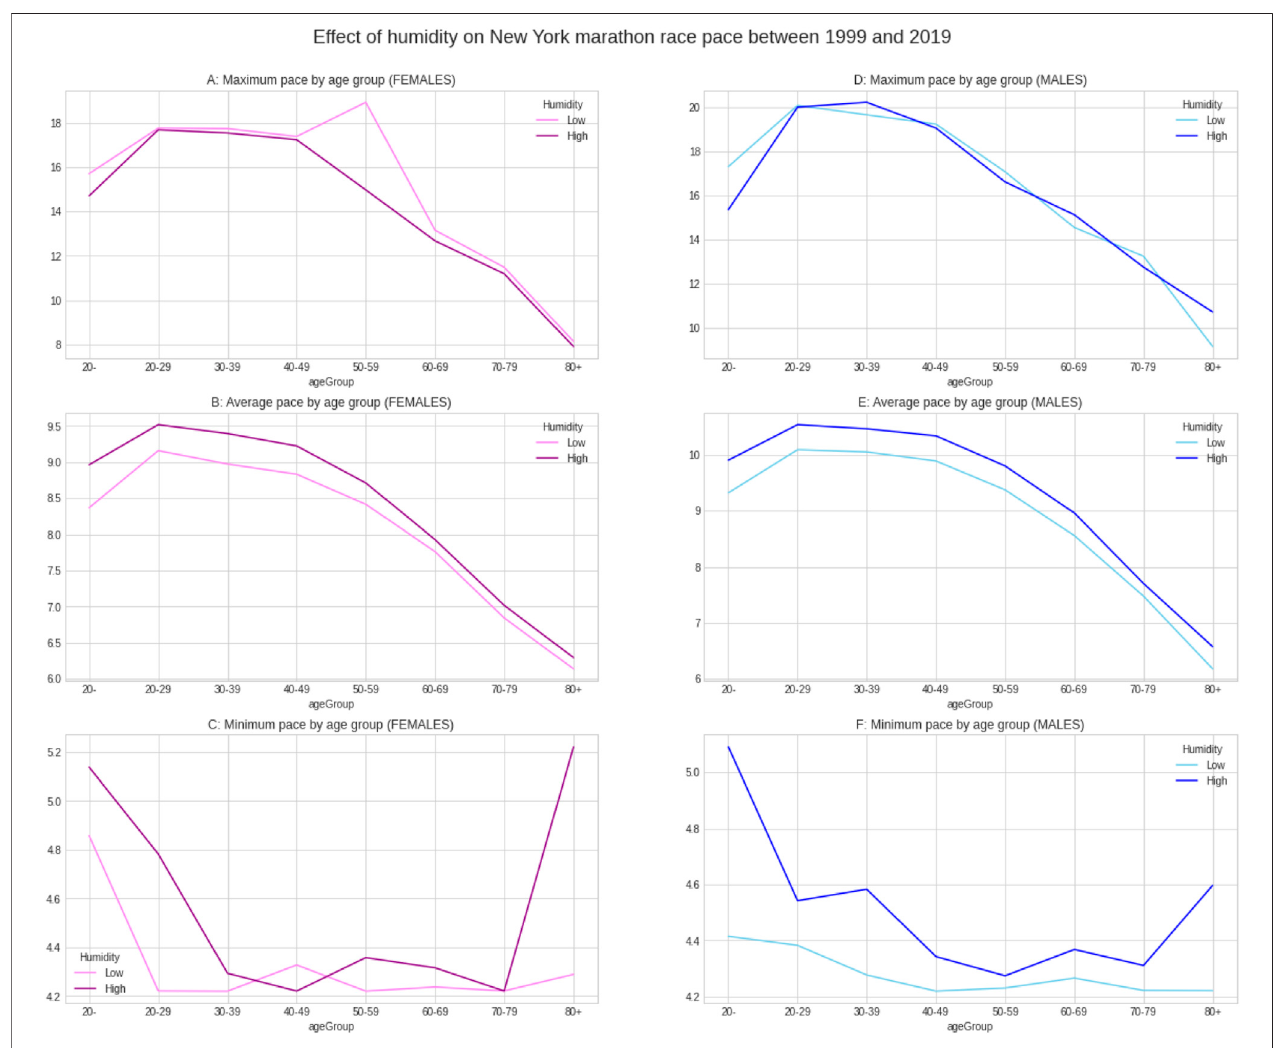
FIGURE 13 | Effect of humidity on running speed by age